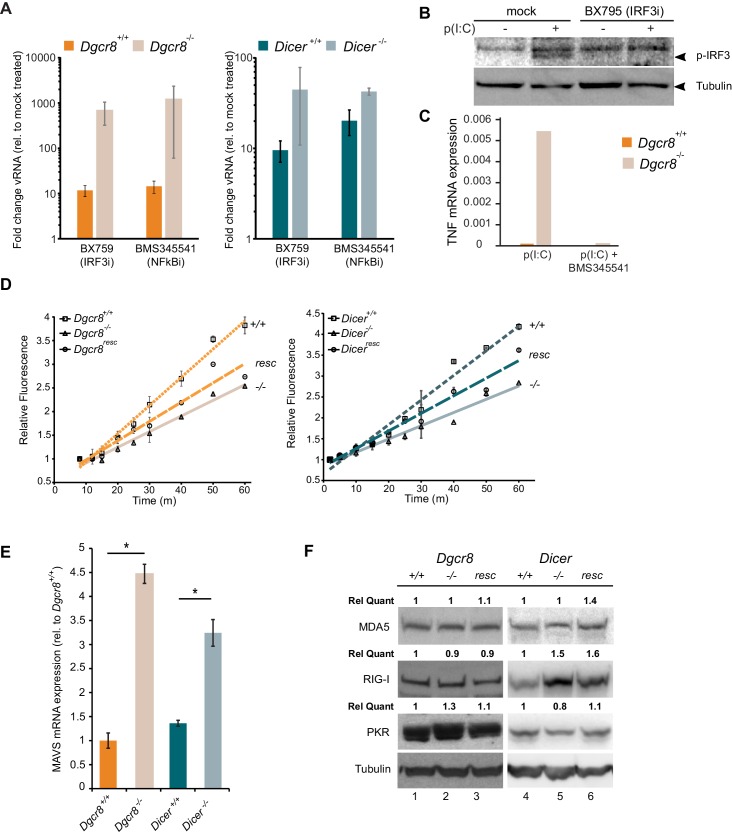
miRNAs regulate MAVS and mitochondrial activity.(a) Treatment of mESCs with inhibitors of IRF3 and NF-κB activation improves viral replication to a much greater extend in the Dgcr8-/- and Dicer-/- cells compared to the parental cells, suggesting that the inhibitory effect that miRNAs have on the IFN response is upstream of these two transcription factors. (b) Western blot analyses of phospho-IRF3 upon stimulation of Dgcr8-/- ESCs with poly(I:C) in the presence or absence of BX759 (inhibitor IRF3 phosphorylation). Tubulin serves as a loading control (c) Quantification of Tnf mRNA upon poly(I:C) stimulation in Dgcr8+/+ and Dgcr8-/- in the presence or absence of BMS345541 (inhibitor of NFkB activation). Data show the average (n = 2) normalized to Gapdh (d) Quantification of oxidative phosphorylation activity by Rhodamine 123 uptake assay in Dgcr8 (left) and Dicer (right) cell lines. (e) qRT-PCR quantification of Mavs mRNA. Mavs expression is higher in the absence of miRNAs (Dgcr8-/- and Dicer-/-), when compared to parental cell lines (Dgcr8+/+ and Dicer+/+). Data show the average (n = 3)±s.d, (*) denotes p<0.05, t-test. (f) Western blot analyses for MDA5, RIG-I and PKR for wild-type cell lines (+/+), Dgcr8 and Dicer KO (-/-), and the respective rescued cell lines (resc). Quantification of the signal normalized to Tubulin and relative to wild-type is shown at the top of each panel.